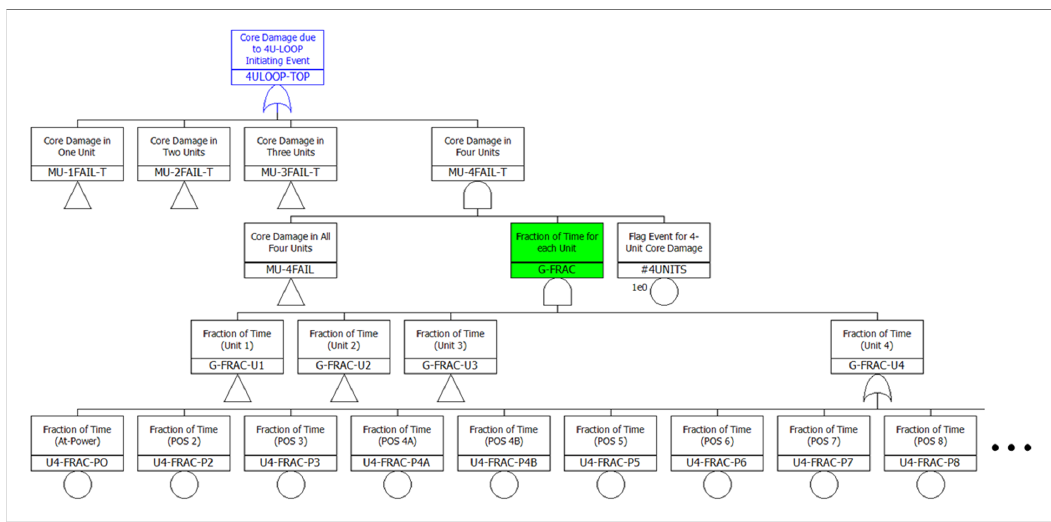
Figure 6. Example logic gate to generate a POS basic event for each unit.